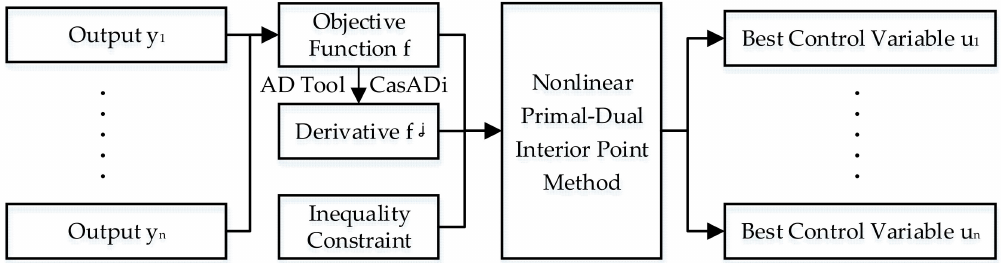
Figure 8. Illustration of the optimization